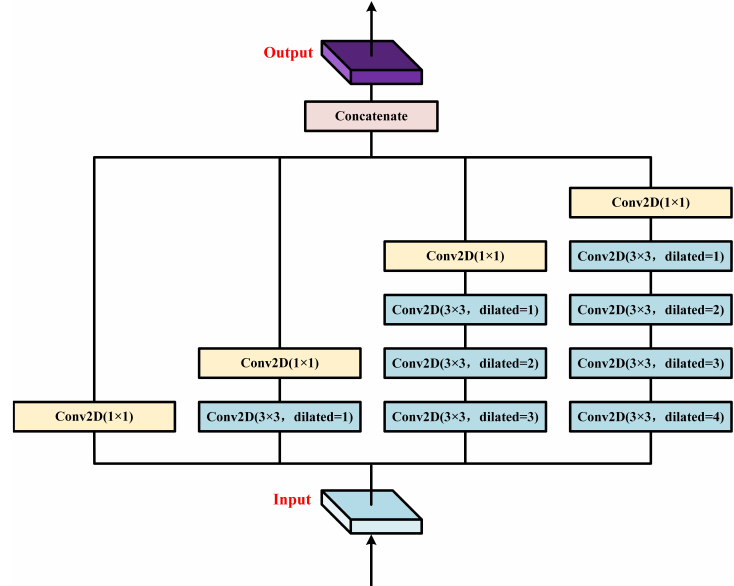
Figure 2. Contextual feature fusion module.